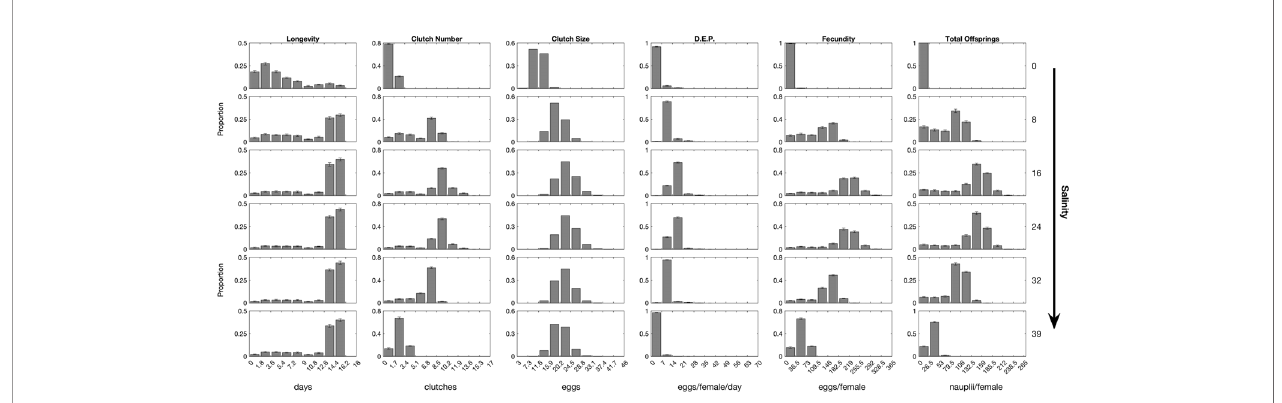
FIGURE 6 | Probability density function of the individual endpoints for 1000 females exposed to different salinities. The histogram represents the average proportion per class over the 15 replicate simulations and the error bars represent the standard